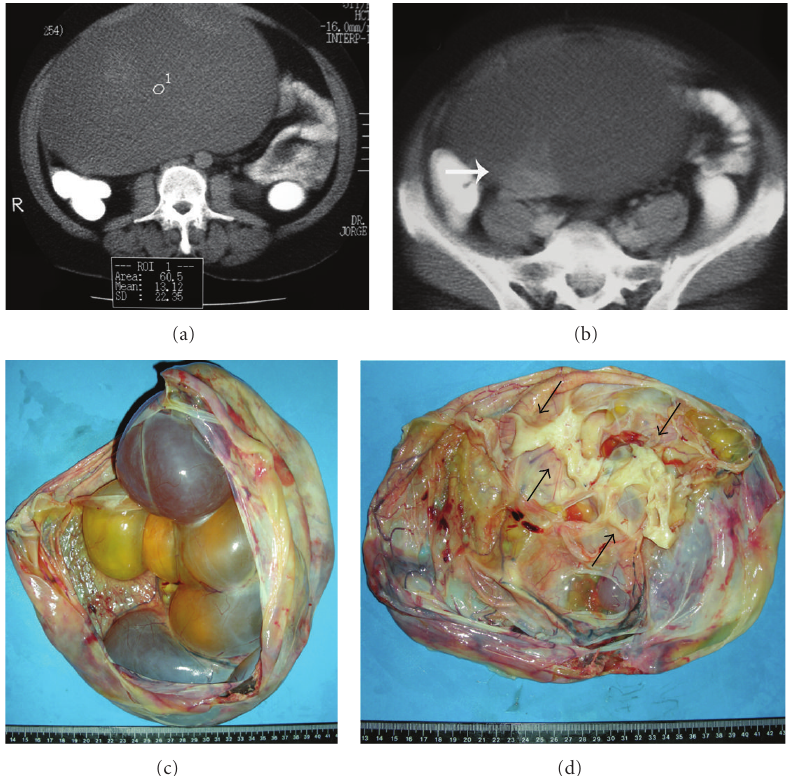
Figure 1: (a) Not contrasted helical computed tomography (CT) of the abdomen; large cyst (water ROI mean 0–20 HU; this cyst 13.12 HU) with well defined limits and finely heterogeneous appearance; (b) Contrast enhanced helical CT of the abdomen; arrow indicates a contrast enhanced solid area in the cyst wall, suggesting malignancy; (c) Partially opened surgical specimen showing the multiloculated cystic appearance, with mucinous content and thin wall; (d) Solid, whitish, and elastic area seen at depth, which corresponded microscopically to the regions with more